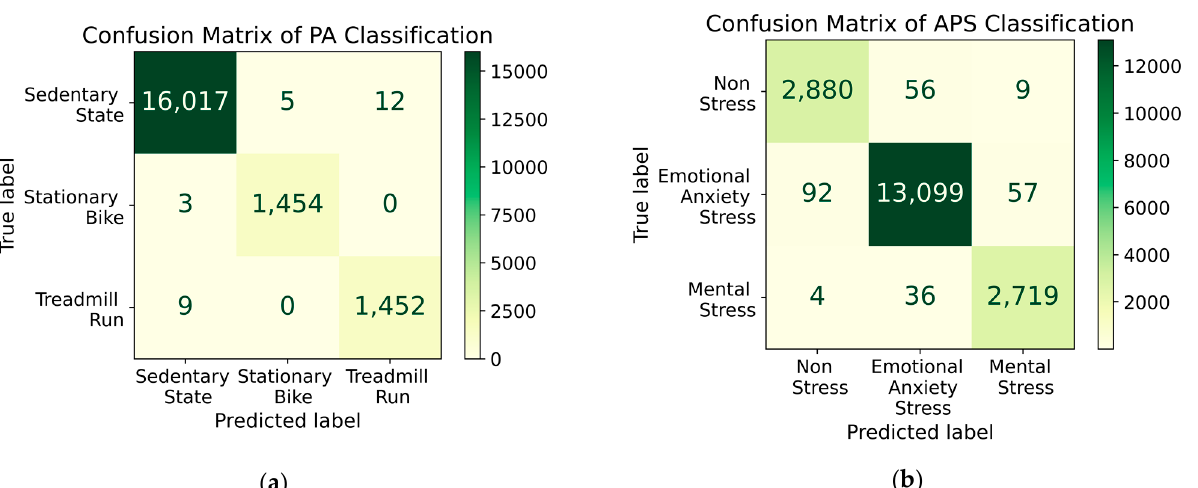
Figure 8. ( a ) Confusion matrix of PA types classification using the independent LSTM RNN (Weighted Training); ( b ) Confusion matrix of APS types classification using the independent LSTM RNN (Weighted Training). Imbalanced classes issue was mitigated by weighted learning approach.